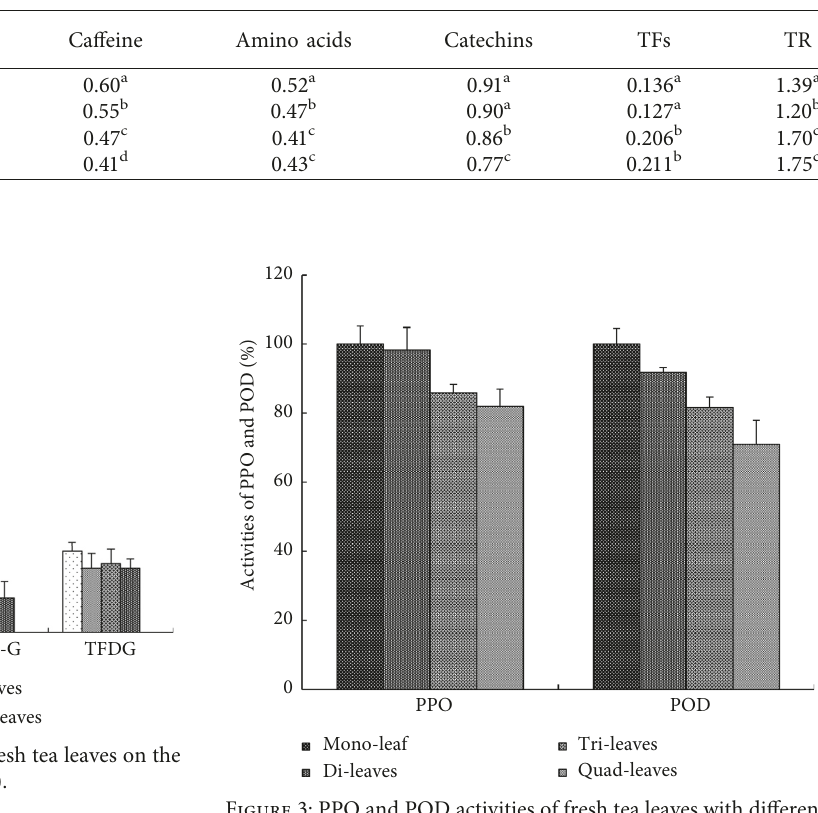
Table 2: Overall acceptability and the concentrations of different chemical components (mg · mL − 1 ) of the fermented juices derived from fresh tea leaves with different plucking